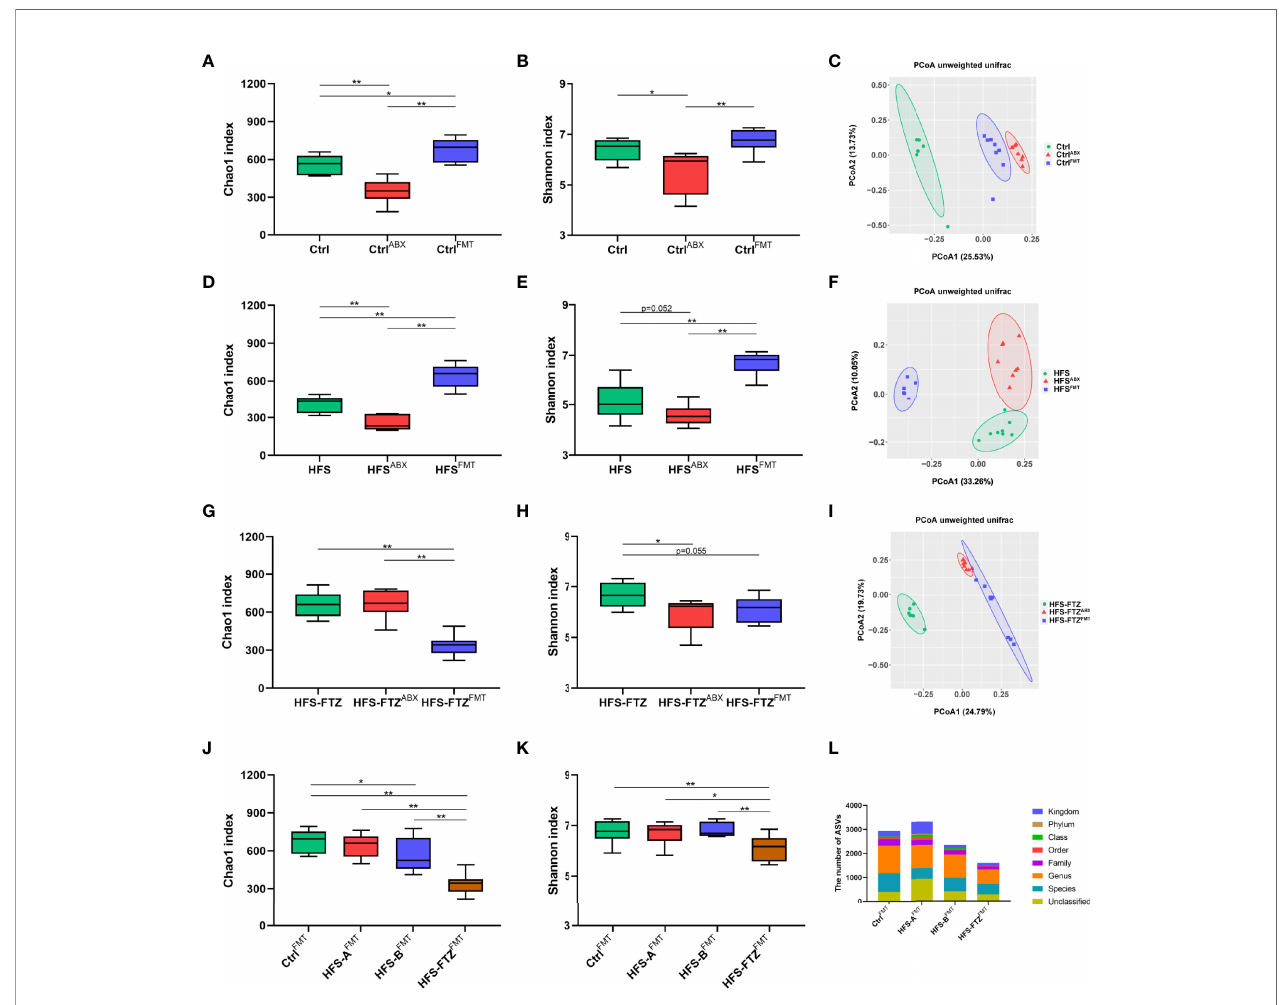
FIGURE 7 | Transplantation with FTZ-modulated intestinal microbiota reshaped gut fl ora in HFS-fed rats. (A – C) Signi fi cant changes in Ctrl group ’ s gut microbiota after ABX and FMT interventions. (D – F) Signi fi cant changes in HFS group ’ s gut microbiota composition after ABX and FMT interventions. (G – I) Signi fi cant changes in HFS-FTZ group ’ s gut microbiota composition after ABX and FMT interventions. (J) Chao1 index after FMT intervention. (K) Shannon index after FMT intervention. (L) ASV number after FMT intervention. ∗ p < 0.05, ∗∗ p < 0.01. n = 6~8 per group. Ctrl ABX , Ctrl group after ABX intervention; Ctrl FMT , Ctrl group after FMT intervention; HFS ABX , HFS group after ABX intervention; HFS FMT , HFS group after FMT intervention; HFS-FTZ ABX , HFS-FTZ group after ABX intervention; HFS-FTZ FMT , HFS-FTZ group after FMT intervention. FTZ, Fufang-Zhenzhu-Tiaozhi capsule; HFS, high fructose and high salt; ABX, antibiotics; FMT, fecal microbiota transplantation; ASV, amplicon sequence